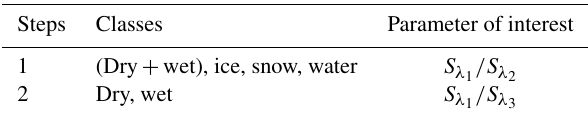
Figure 5. Average backscattering spectra measured for different road surface conditions. The spectra were averaged over all tested configurations. Table 2. Classification method for the detection of the road surface